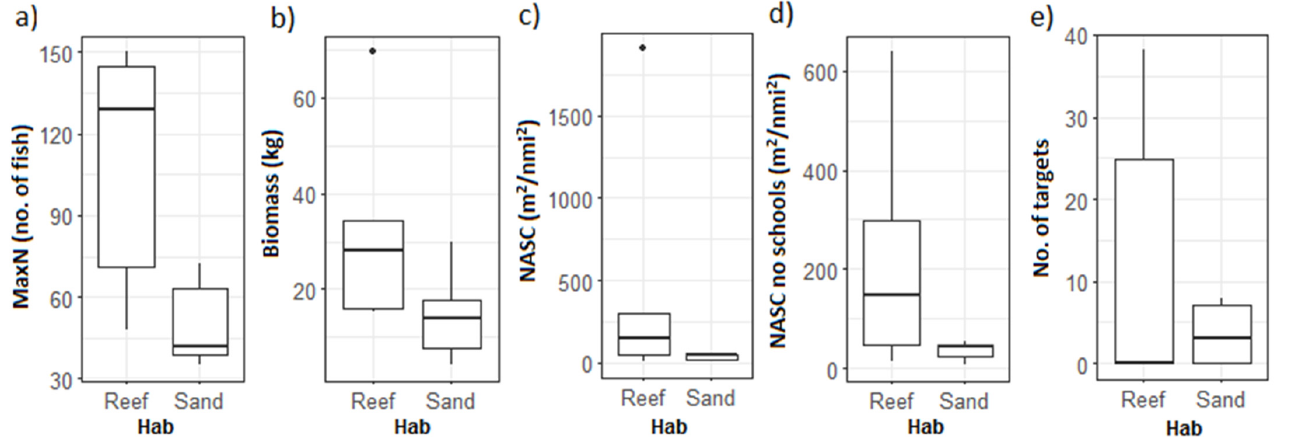
Figure 6. Box plot of the ( a ) relative abundance from the stereo-BRUVs (MaxN), ( b ) relative biomass from the stereo-BRUVs (kg), ( c ) acoustic NASC BRUV-mean , ( d ) acoustic NASC BRUV-mean no schools, and ( e ) acoustic targets grouped by benthic habitat class.